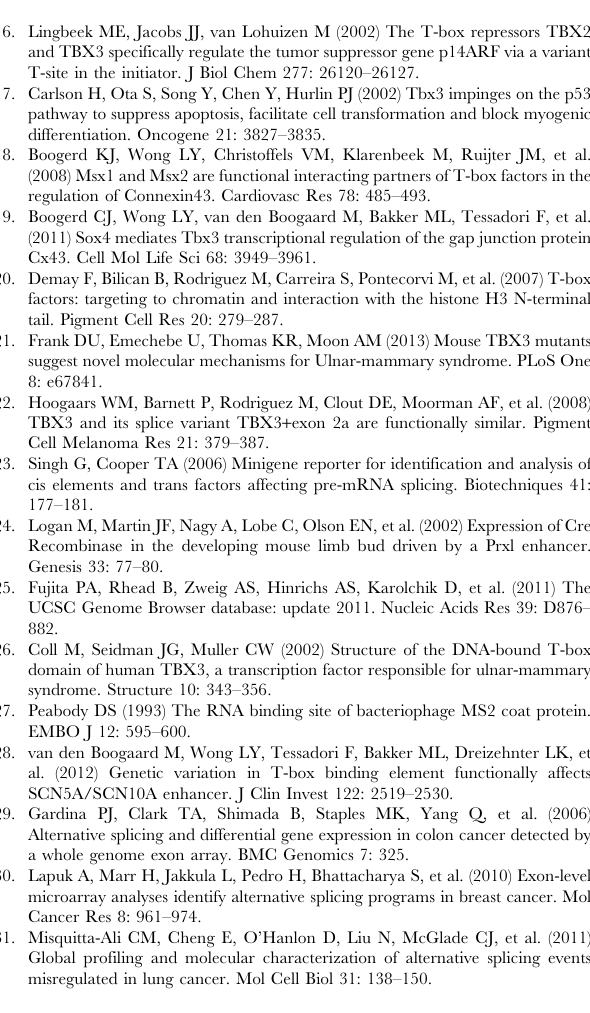
control antibody rabbit IgG (R-IgG). G) RNA probe containing GGUGU motifs. Probe/protein complex (lane 2) supershifts with Anti-TBX3 antibody (lanes 3) but not with R-IgG (lane 5). TBX3 + RNA complexes are indicated by blue arrowhead, anti- Tbx3 antibody supershifted TBX3 + RNA complexes are indicated by red arrowhead and unbound probe by black arrowhead. H) RNA probe containing AGGUGU motif from Nfkb1 Fragment 3. Probe/protein complex (lanes 2, 3, 5) supershifts with Anti-TBX3 antibody (lane 2) but not with R-IgG (lane 5). TBX3 + RNA complexes are indicated by blue arrowhead, anti-Tbx3 antibody supershifted TBX3 + RNA complexes are indicated by red arrowhead and unbound probe by black arrowhead. Table S1 TBX3 interacting proteins meeting MS screen criteria. Table S2 Validation results of randomly selected alternatively spliced target ordered by statistical significance. Table S3 RNA-Seq analysis of anterior limb compartment control versus Tbx3 mutant transcripts. Data and significance are provided for both expression fold change and splicing variants detected.